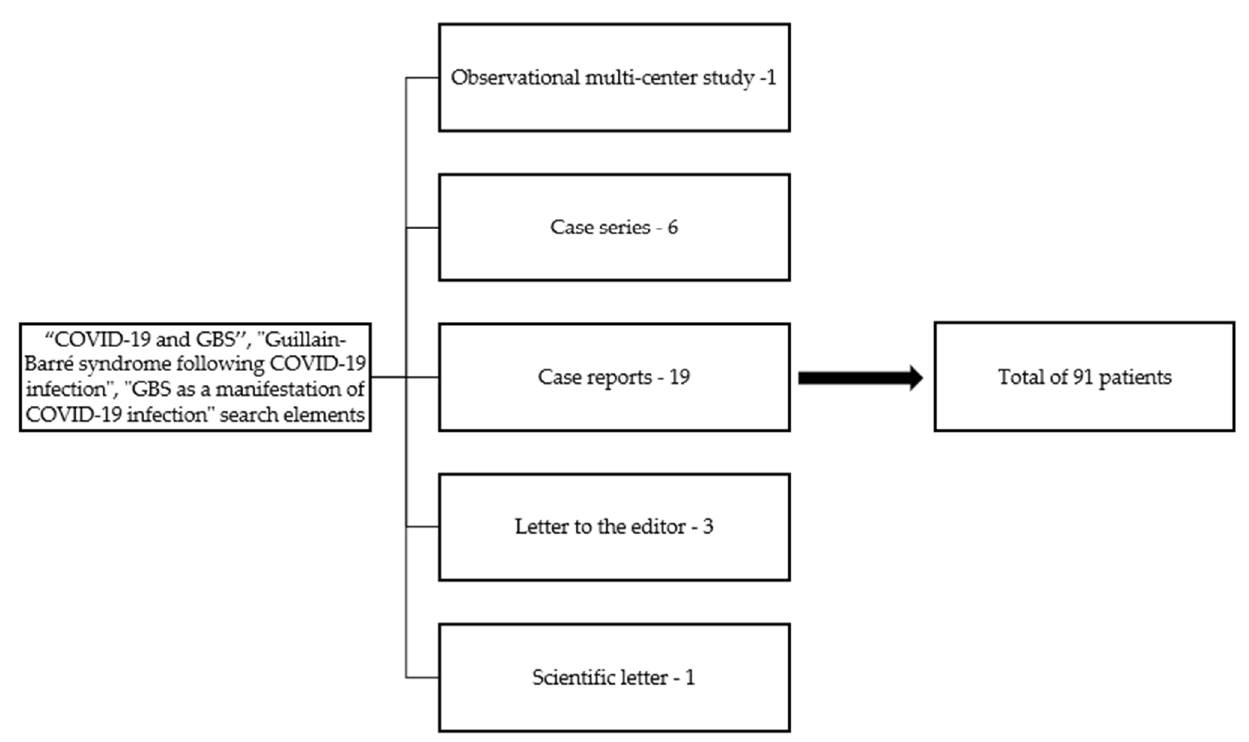
Figure 1. Article Figure 1. Article selection.